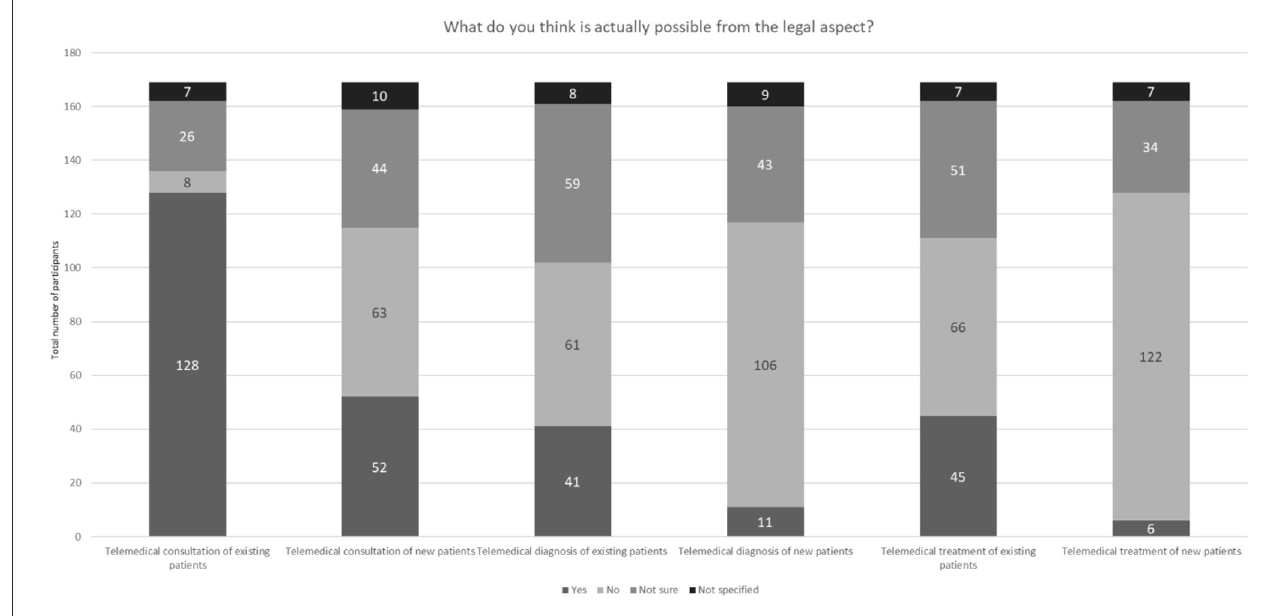
FIGURE7 Legal possibilities in veterinary medicine in terms of telemedicine ( N = 169).